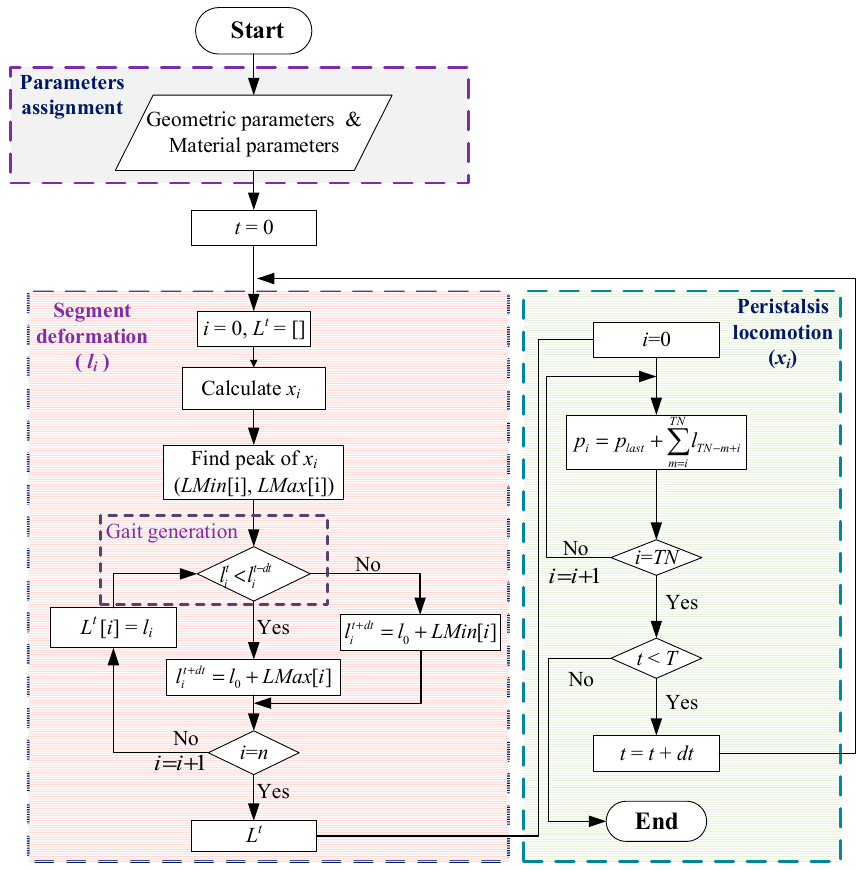
Figure 9. Routine of locomotion simulation of the earthworm-like robot driven by ultra-low frequency excitation.